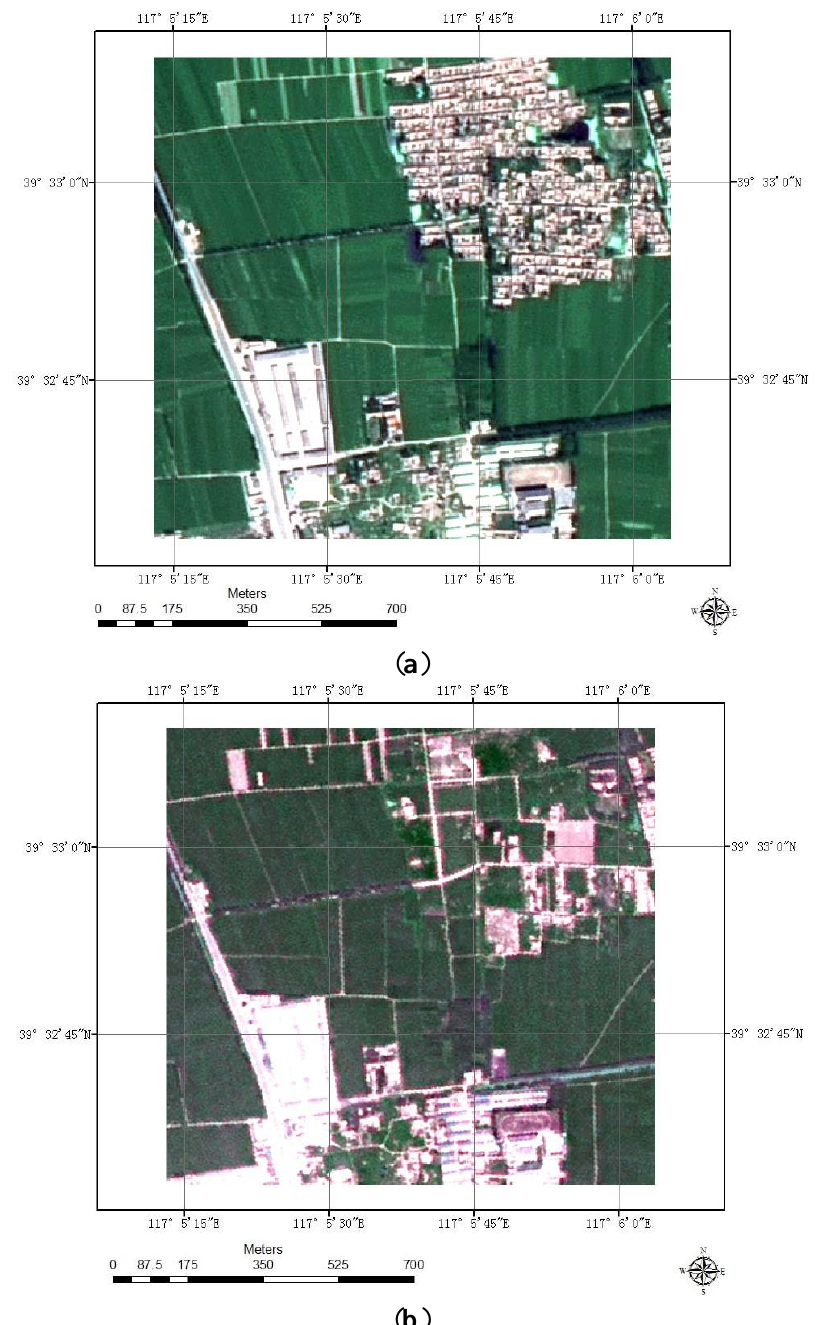
Figure 2. Two date images of the same area. ( a ) t acquired in